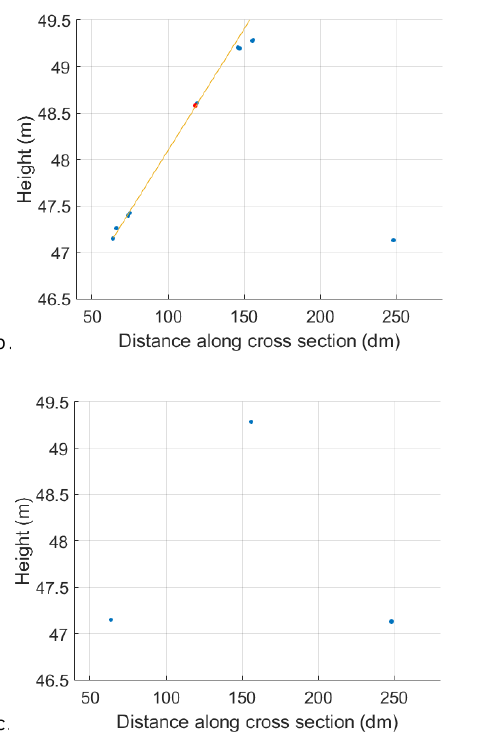
Figure 5. Cross sections of a gable roof from (a) the nDSM, (b) the least squares fitted line using Canny detected edges with extracted heights, and (c) the final result of scan line segmentation.